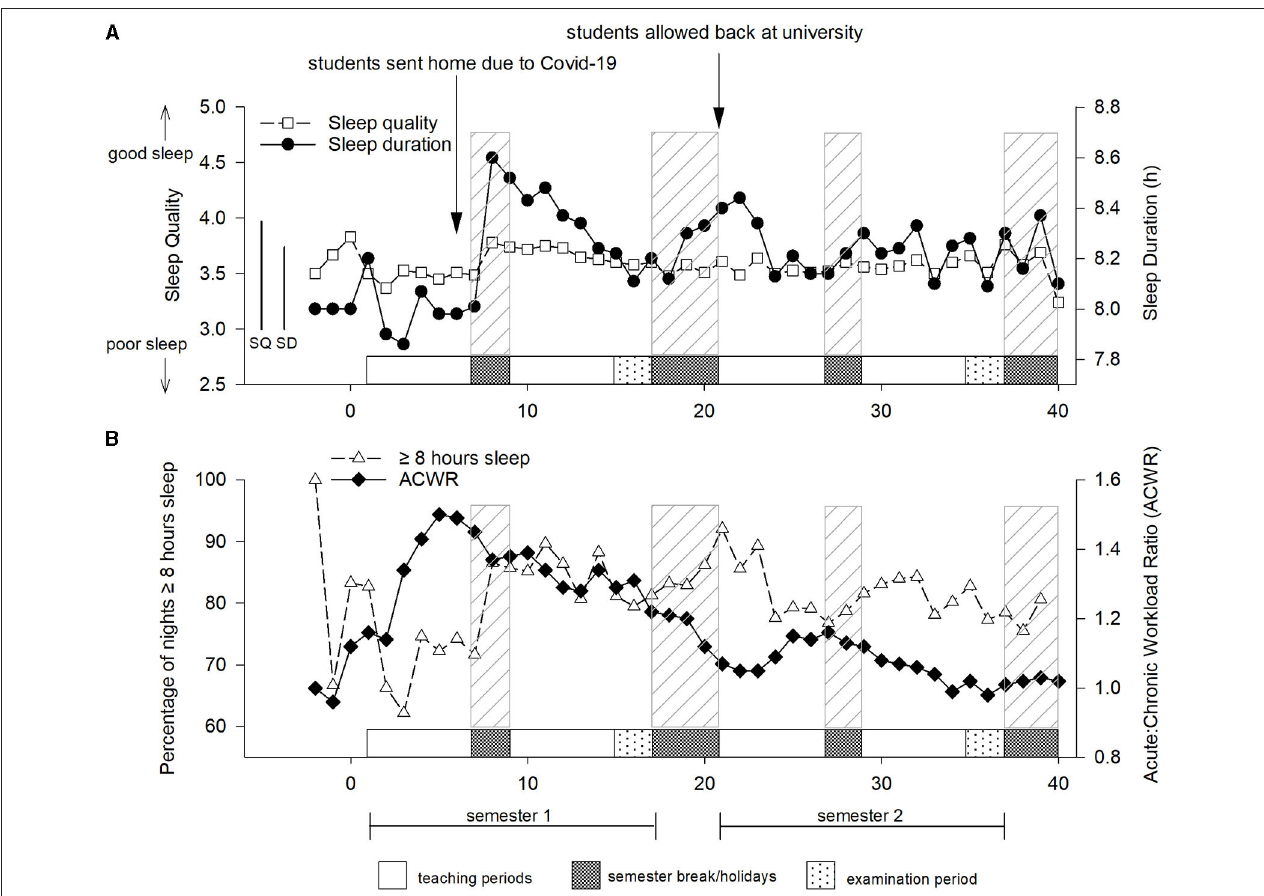
FIGURE 2 | (A) Perceived sleep quality and duration, (B) percentage of nights slept ≥ 8h and Acute:Chronic workload ratio (ACWR) in young elite university athletes during the university year. Values are weekly means. SQ, Sleep quality overall between-subject standard deviation; SD, Sleep duration overall between-subject standard